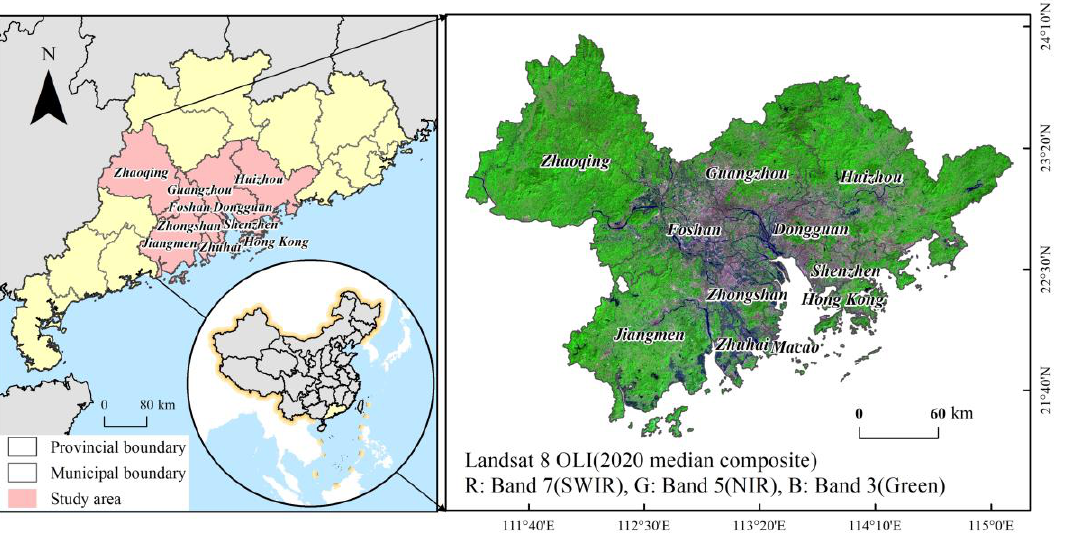
Figure 1. Location of the study area: the Guangdong-Hong Kong-Macao Greater Bay Area.